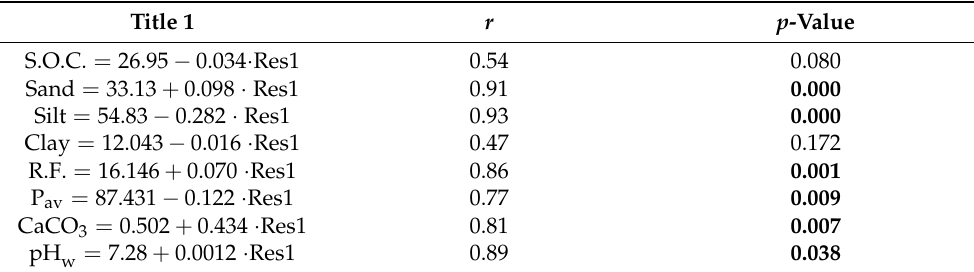
Table 2. Models of soil properties as a function of soil resistivity with the corresponding correlation coefficient ( r ) and significance level ( p -value).